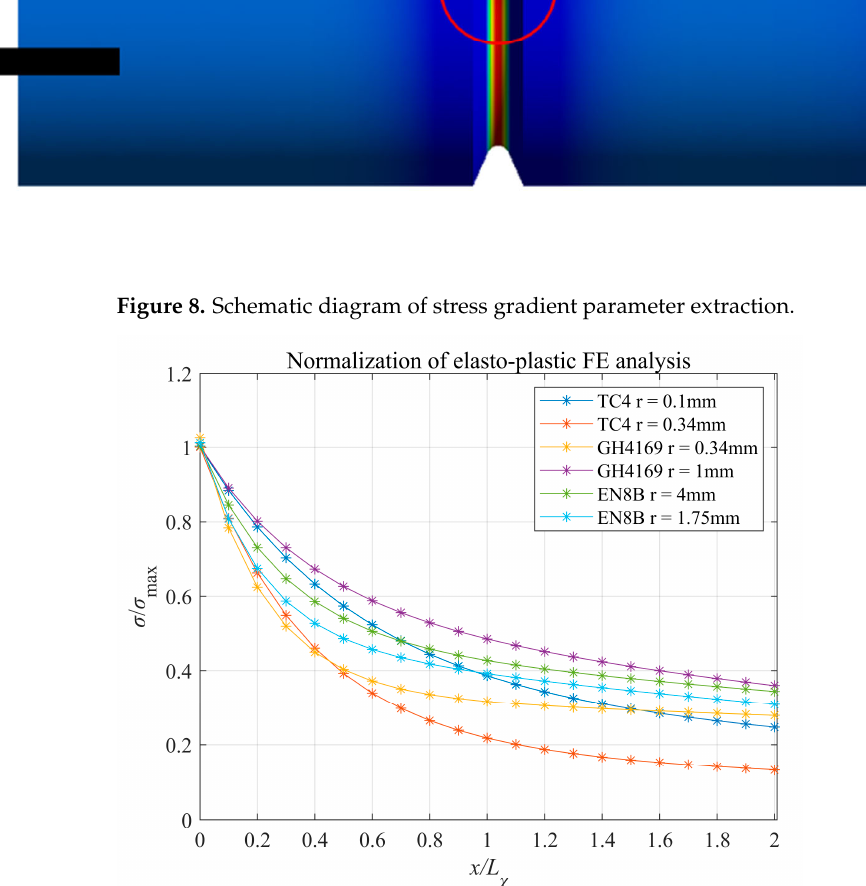
Metals 2023 , 13 , x FOR PEER REVIEW 12 of 17